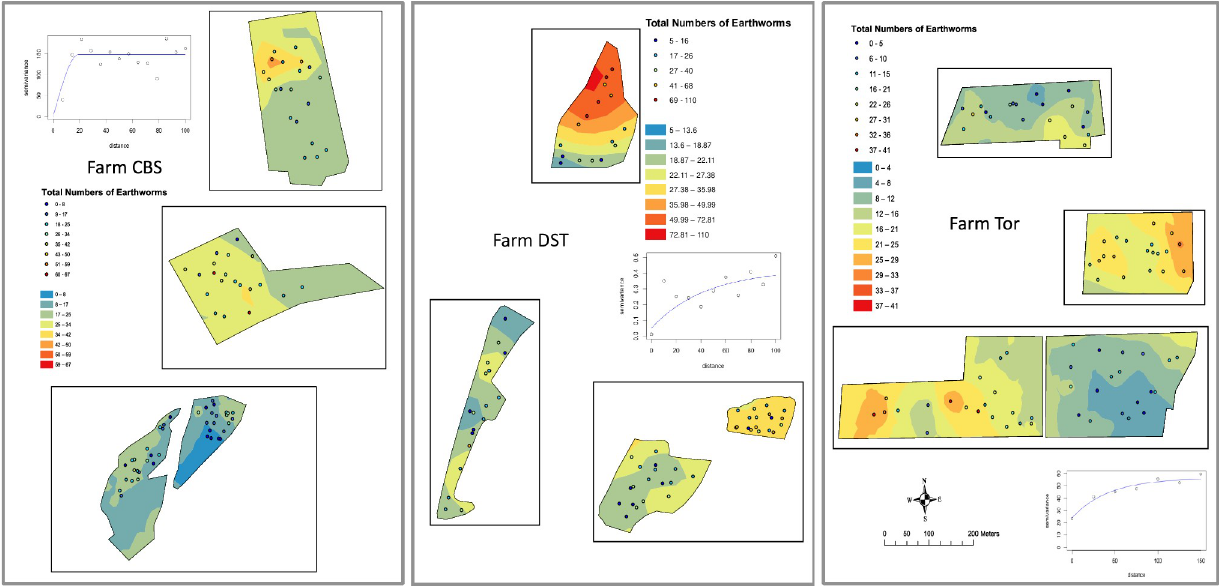
Fig 5. Within field and farm distribution of earthworms for each of the four fields at three representative sites, a) CBS, b) DST and c) SKF. Contoured colours represent the interpolated (predicted) values of total earthworm counts, coloured dots represent the observed counts within each sampling point. Inserts show the variograms used to generate the interpolated surfaces, with the separation distances on the x-axis, and semivariance (earthworm counts, log for DST) on the y-axis.